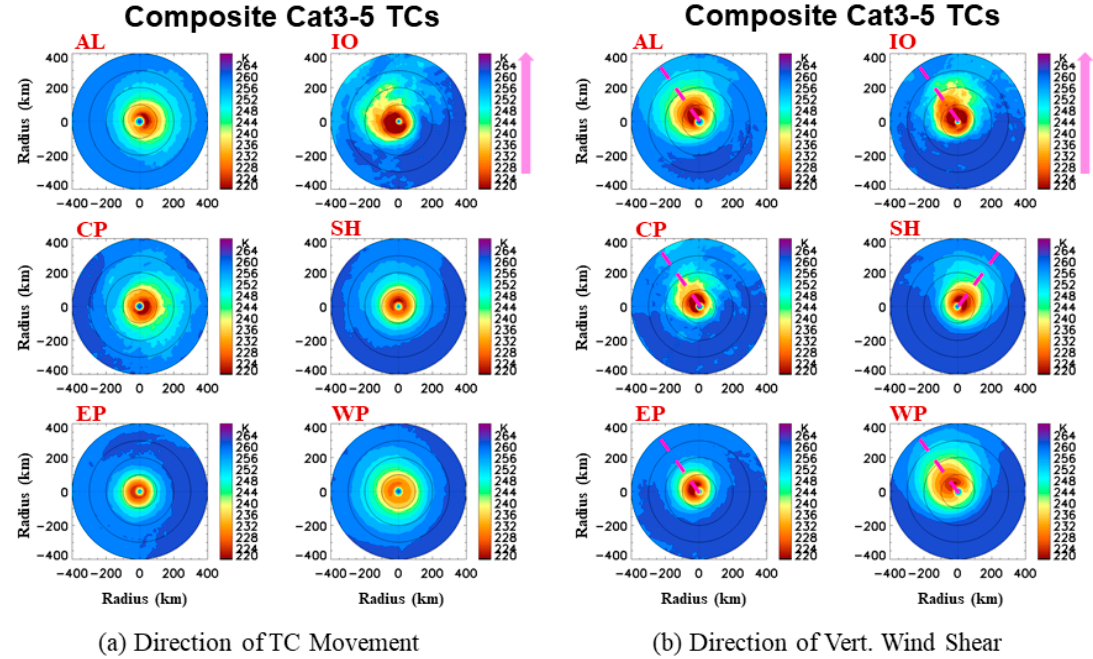
Figure 9. Distributions of the 89H GHz TBs over six basins in 1987–2012 for the composite Cat 3–5 TCs relative to ( a ) direction of TC movement and ( b ) direction the 200–850 hPa wind shear. The red dashed line in ( b ) is for axis of the minimum